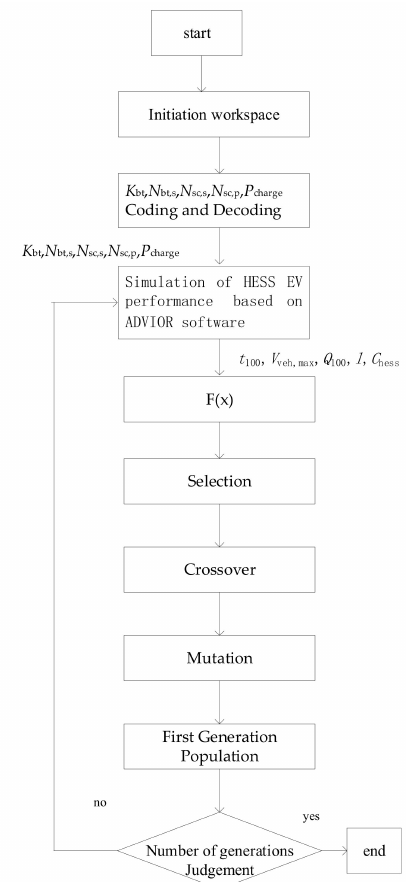
Figure 4. The flowchart diagram of the HESS